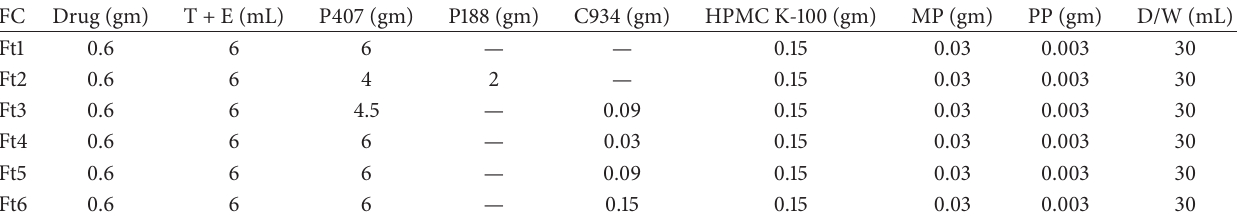
Table 1: Composition of the drug loaded formulations containing tween 80 and ethanol.